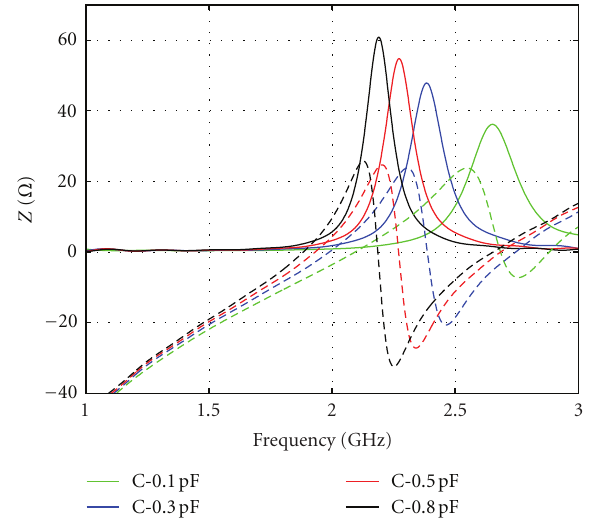
Figure 9: Frequency behavior of the real (solid lines) and imaginary (dashed lines) part of the antenna input impedance versus the PIN diode capacitance